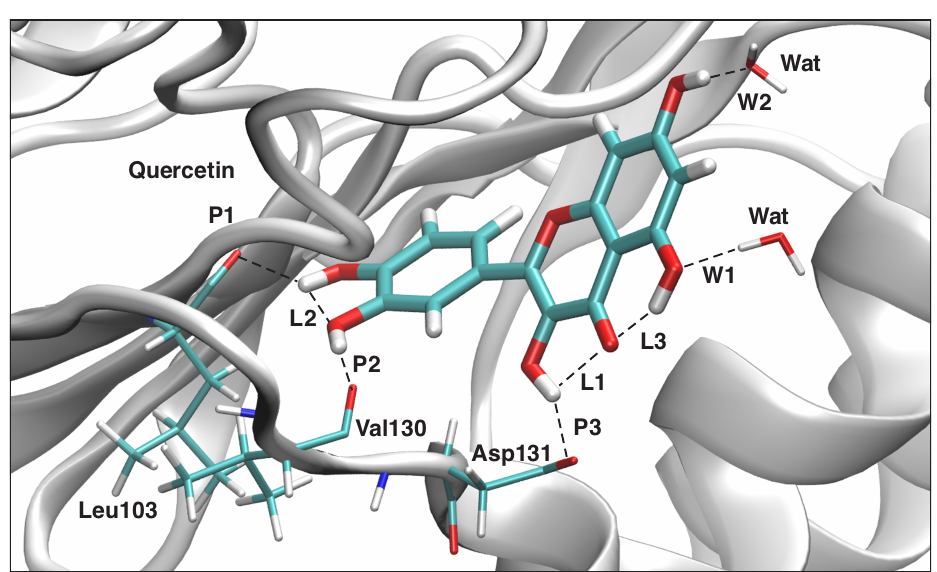
Figure 15. Optimized geometry of the Quercetin-NS5 complex. The QM part includes Quercetin, indicated by bold sticks; the MM part includes the NS5 protein, water molecules, and counter ions (for further details, see Supporting Information). There are eight hydrogen bonds (dashed lines) between Quercetin and the Leu103, Val130, and Asp131 residues (thin sticks) of NS5, between Quercetin and the two water molecules, and between three intramolecular hydrogen bonds; see also Figure 16. (Number of QM atoms: 32, total number of atoms: 14,116). ω B97X-D/6-31G(d,p)/AMBER level of